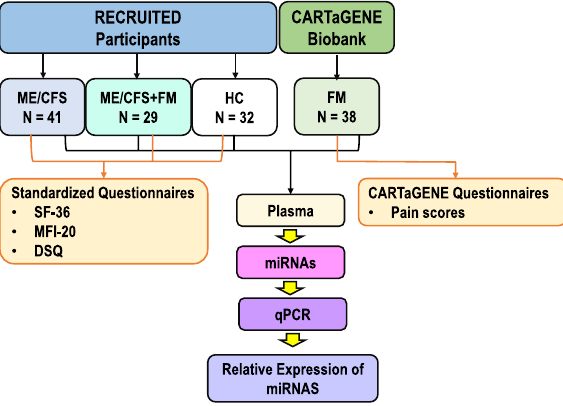
Figure 1. Representation of the experimental study